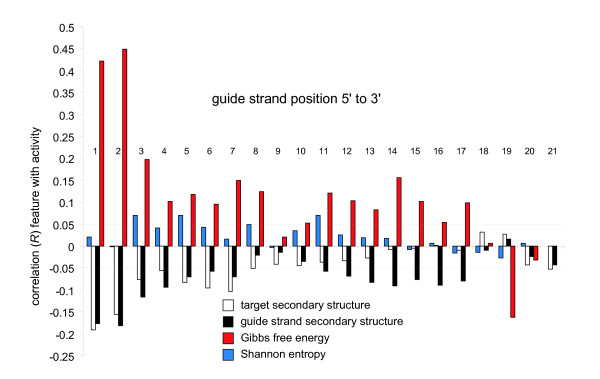
Guide strand secondary structure, thermodynamics, entropy and target secondary structure position specific correlation coefficients with RNA interference activities. Thermodynamics and entropy correlation measures comprise a 2 nucleotide sliding window. Secondary structures can be interpreted as the relative contribution of this position being within a secondary structure and that contribution leads to RNAi activity. Position 1 is the 5' most position of the guide strand.